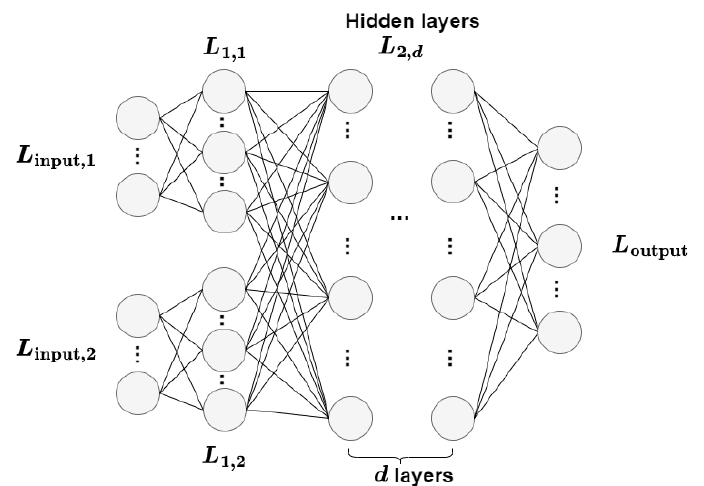
Figure 6. Graphical diagram of neural network structure for model H 1